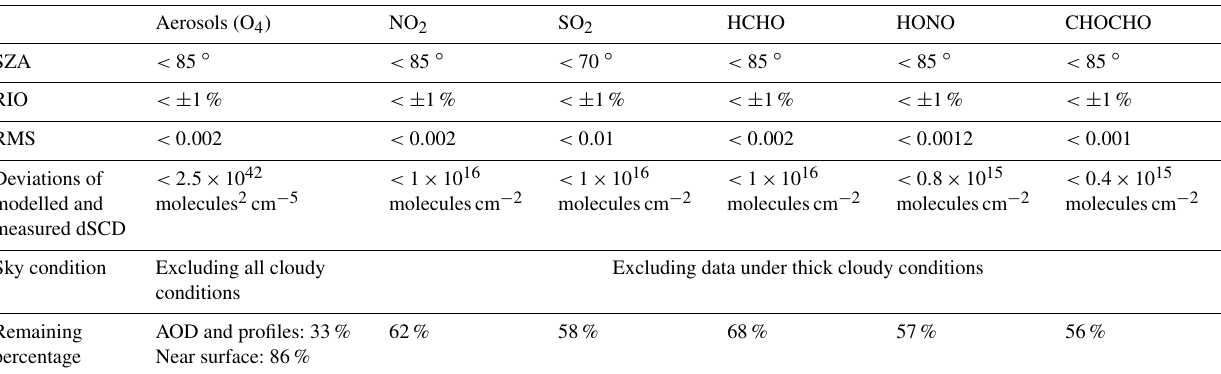
Table 2. Different filters and corresponding thresholds applied to the MAX-DOAS results. The thresholds are experientially determined to exclude most outliers. Also the corresponding fractions of remaining data are indicated (SZA is solar zenith angle; RIO is relative intensity offset in the DOAS fit; RMS is root-mean square of the residual in the DOAS fit). Aerosols (O 4 ) NO 2 SO 2 HCHO HONO